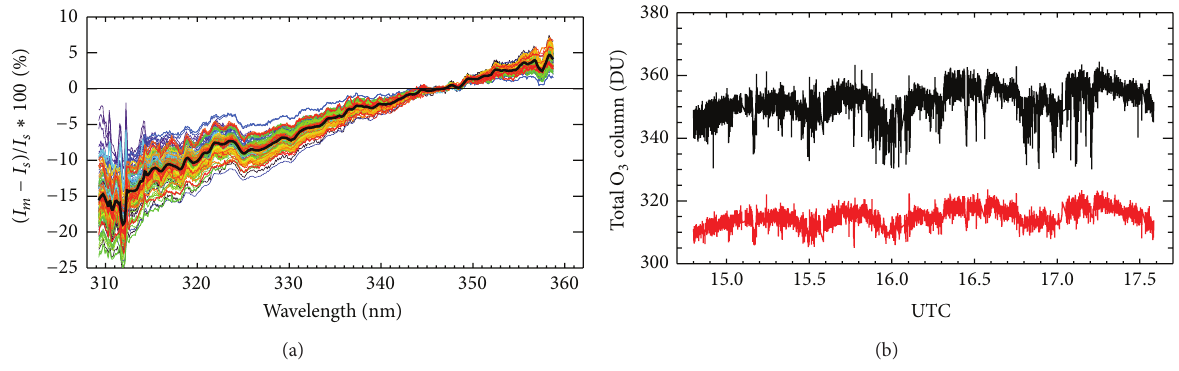
Figure 2: (a) Difference between ACAM ( 𝐼 𝑚 ) and simulated ( 𝐼 𝑠 ) radiance versus wavelength for 158 ozonesonde/ACAM collocations (within 2 hours and 1km) in different colors, for the 2011 DISCOVER-AQ flight campaign. The average difference (black) is used as the empirical radiometric correction. (b) Retrieved total ozone column with (black) and without (red) using the derived empirical correction from ACAM radiance in the spectral region 318–335 nm from July 21, 2011, using the optimal estimation based ozone profile algorithm.